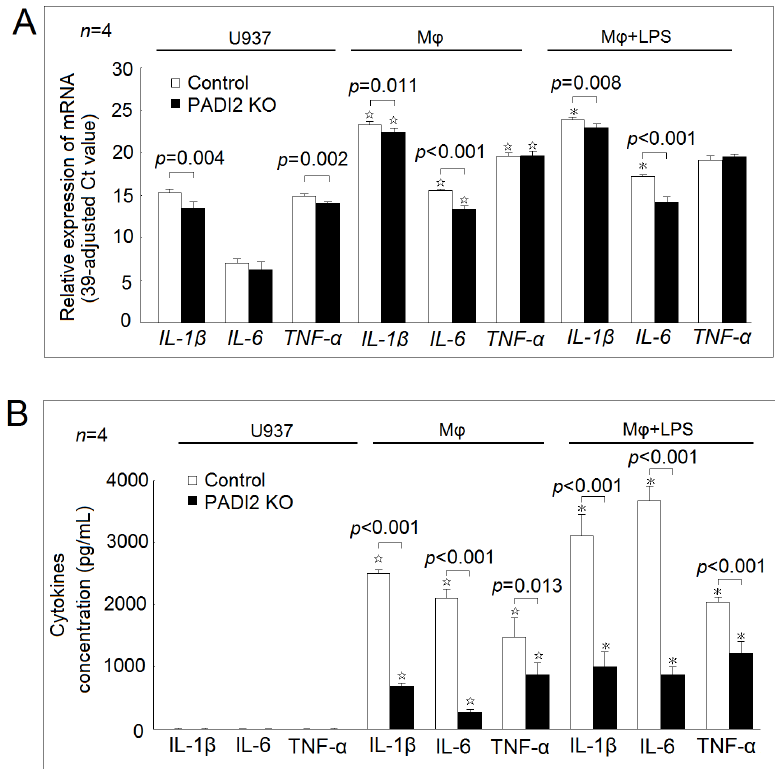
Figure 2. Effects of PADI2 knockout on inflammatory cytokines expression and secretion. ( A ) The mRNA expression levels of IL-1β , IL-6 , and tumor necrosis factor-alpha ( TNF-α ) in the U937 cells, the differentiated macrophages, and the macrophages stimulated with LPS in the PADI2 knockout group compared with those in the controls. ( B ) The cytokines secretion levels of IL-1β, IL-6, and TNF-α in